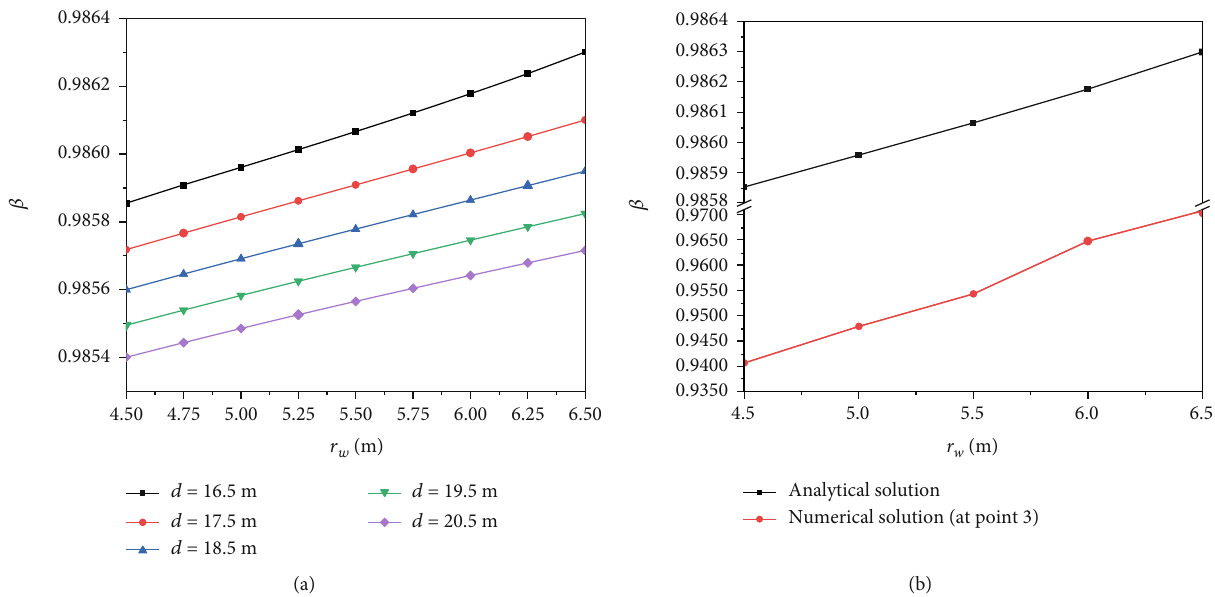
Figure 7: Relationship between β and r